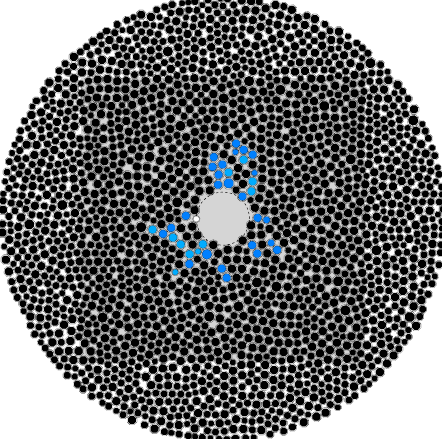
Figure 21. The bonding condition of the B1H15 model before the onset of sand production. Black particles represent particles with intact bonds (without any breakages). Dark blue particles denote particles with few broken bonds (less than half of the initial bonds), and light blue particles represent particles with a large number of broken bonds (more than half of initial bonds). White particles are purely frictional with no remaining bonds.